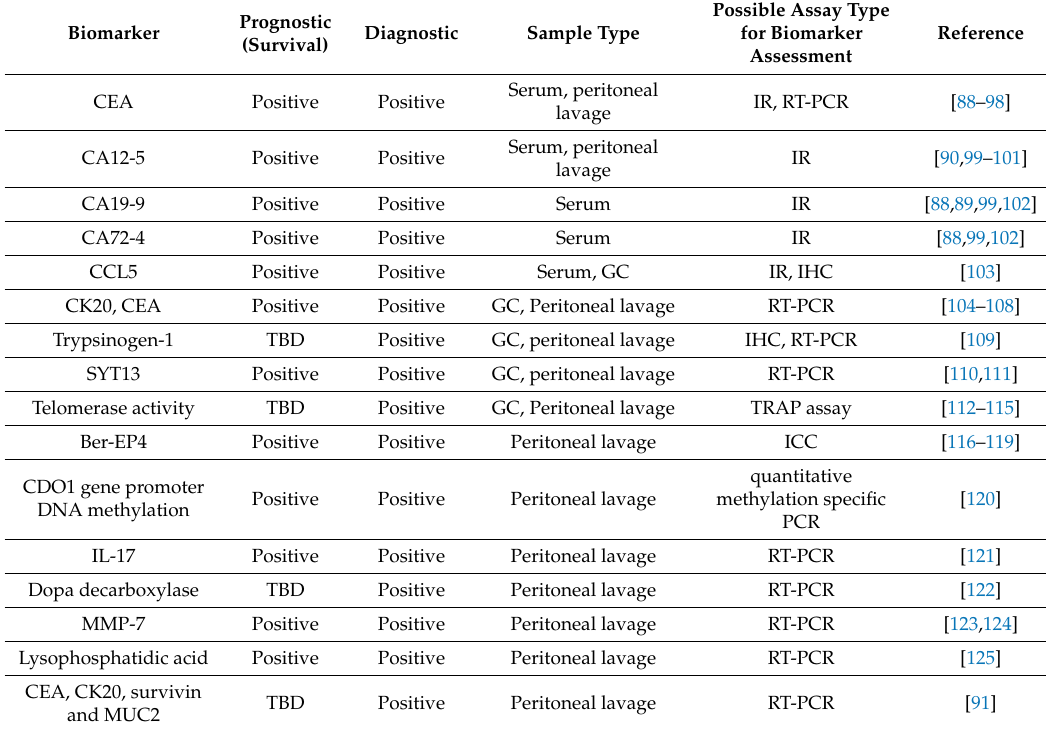
Table 1. Diagnostic and / or predictive biomarkers for peritoneal dissemination of gastric cancer.